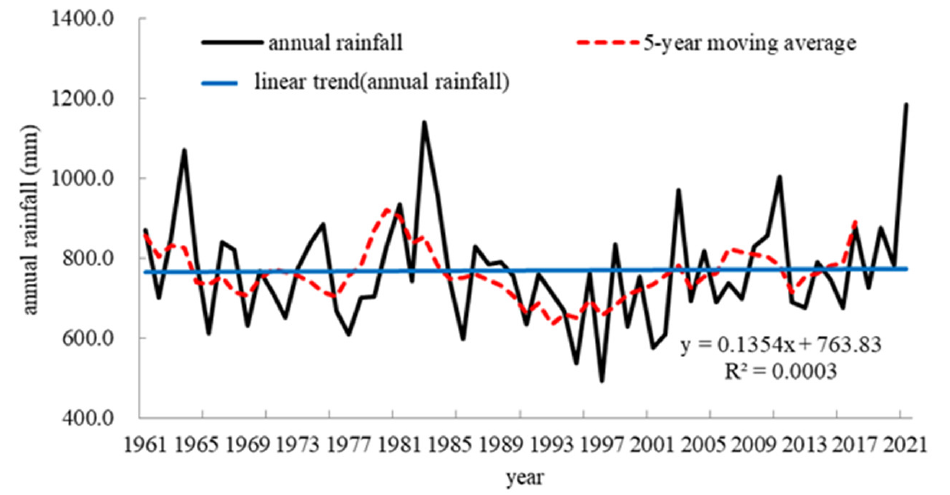
Figure 3. Time series of regionally averaged annual mean rainfall amount (AMRA) (unit: mm) from 32 stations in the QMs during the period 1961–2021. The black line denotes the rainfall curve, the red dashed line denotes the 5-year moving average curve, and the blue line denotes the linear trend curve.